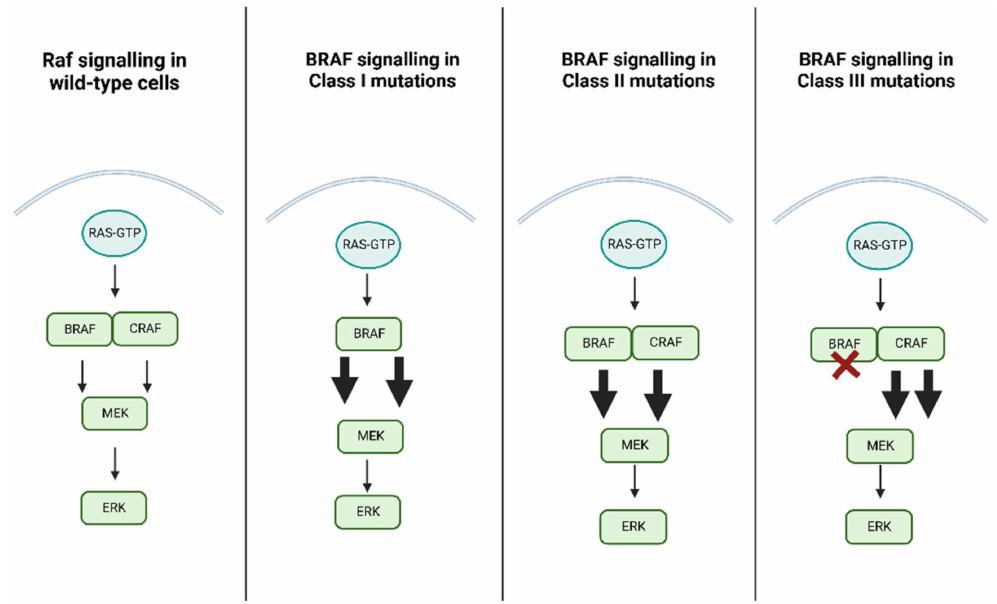
Figure 2. This image shows the physiological regulation and dimerization of BRAF and CRAF in wild- type cells. Class I mutations signal as monomers with autonomous kinase activity. Class II mutations signal constitutively as dimers independently of RAS activity. Class II mutations have low or absent kinase activity and are dependent to RAS and need dimerization to activate the pathway. The slim arrows represent physiological kinase activity. The wide arrows represent kinase activity induced by mutations. The red cross symbolizes absent kinase activity as a monomer in Class III